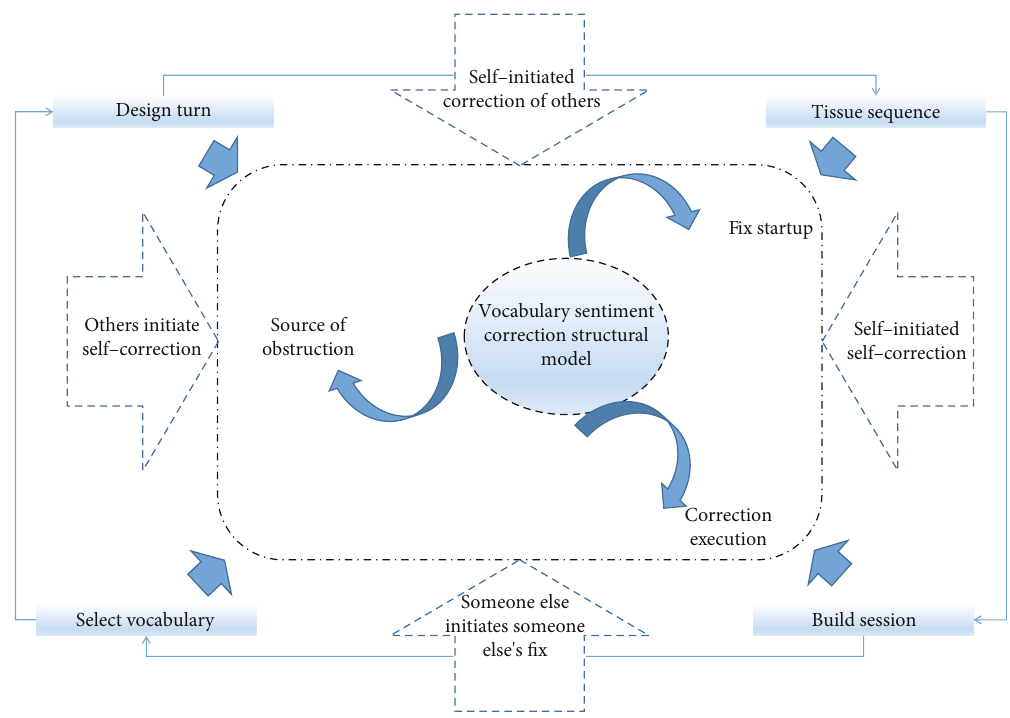
Figure 1: The mode of vocabulary emotion correction of Chinese as second language